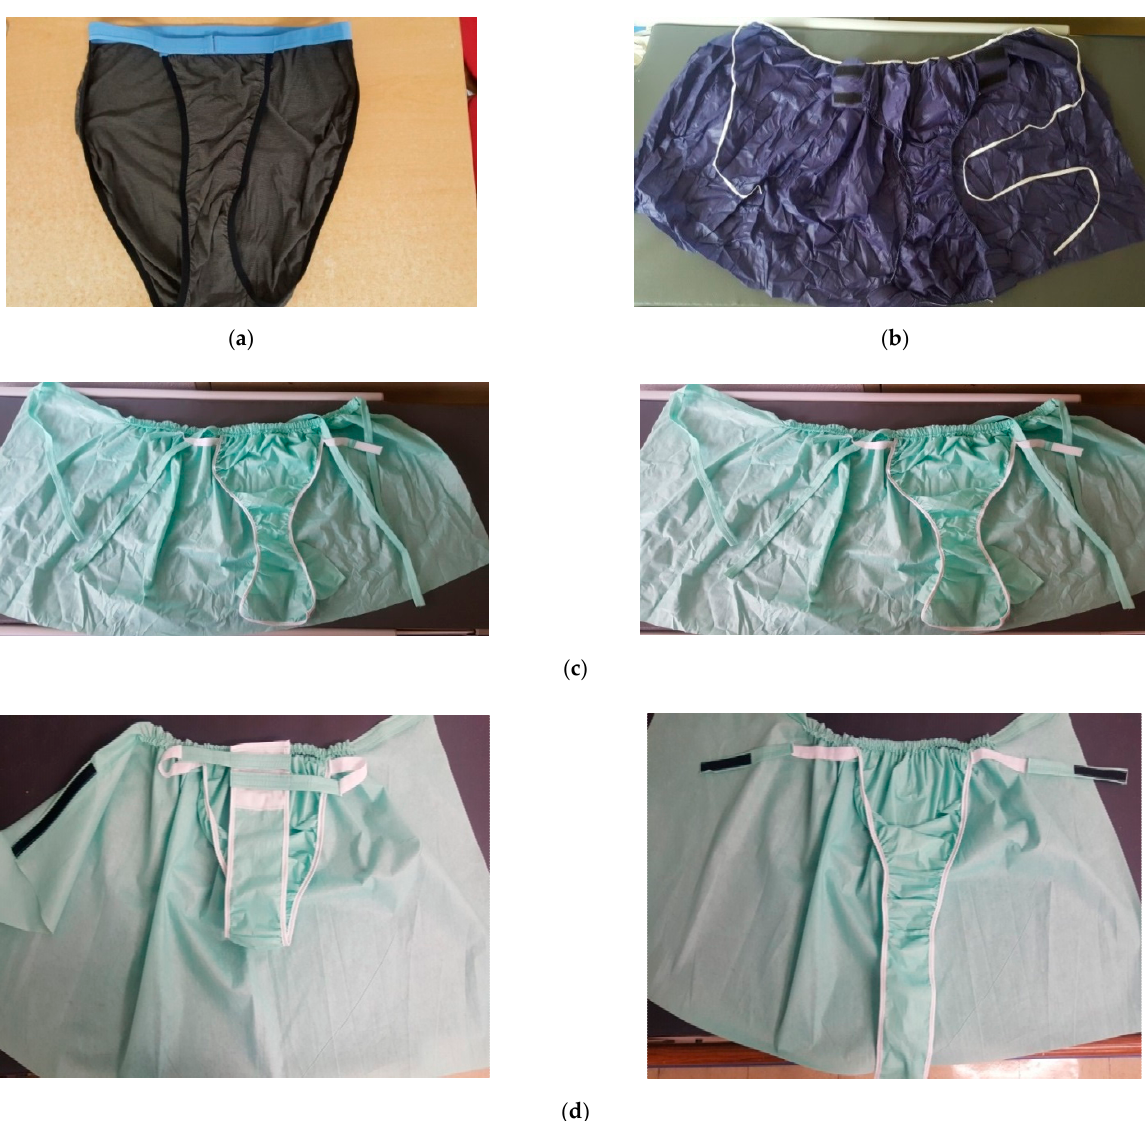
Figure 1. Developed Perineal Underwear. ( a ) First Version of the Perineal Underwear; ( b ) Second Version of the Perineal Underwear; ( c ) Third Version of the Perineal Underwear; and ( d ) Final Version of the Perineal